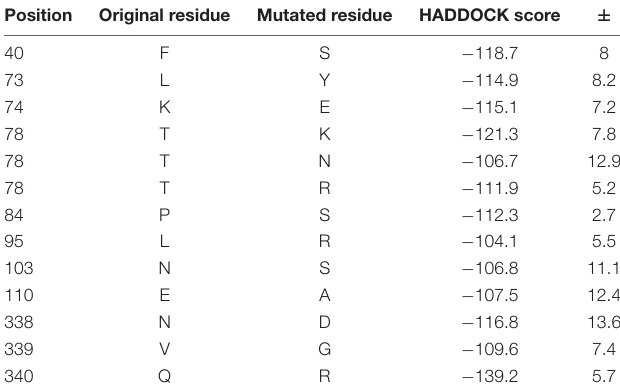
TABLE 4 | The HADDOCK scores of mutated